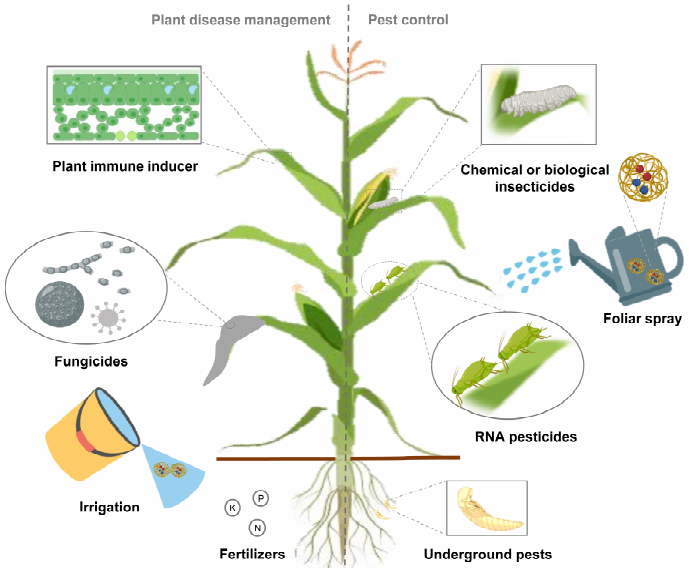
Figure 2. Application of co-delivery system is promising in agricultural field. Fabrication of co-delivery nanopesticide system, assembled with insecticides, fungicides or fertilizers, achieves synergistic effects or multiple aspects of drug administration simultaneously.